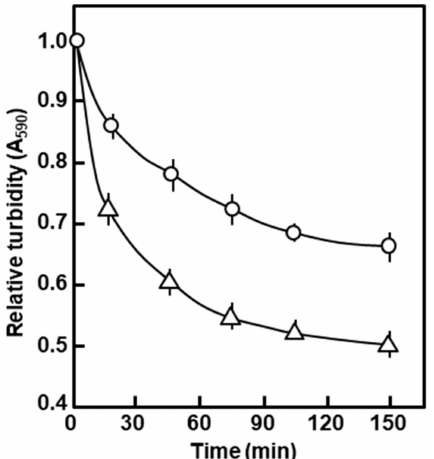
Figure 4. Autolysis of the polylysogen in the stationary suspension. The polylysogen ( ∆ ) and nonlysogen (o) were resuspended and held in phosphate bu ff er without shaking; turbidity (A 590 ) was followed with time, and presented as a fraction of the starting turbidity, taken as 1.